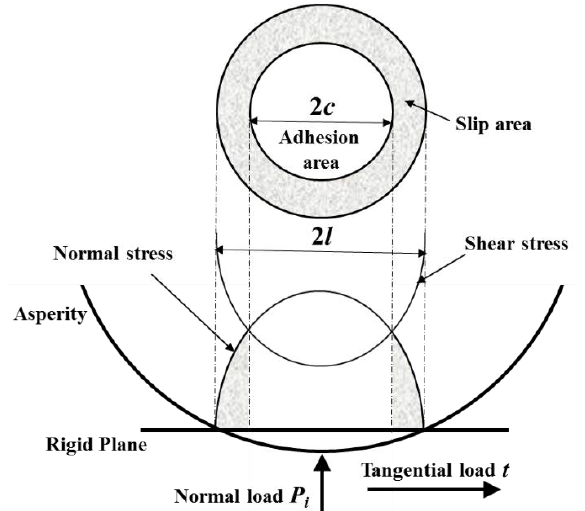
Figure 3. Contact of asperity under tangential load.